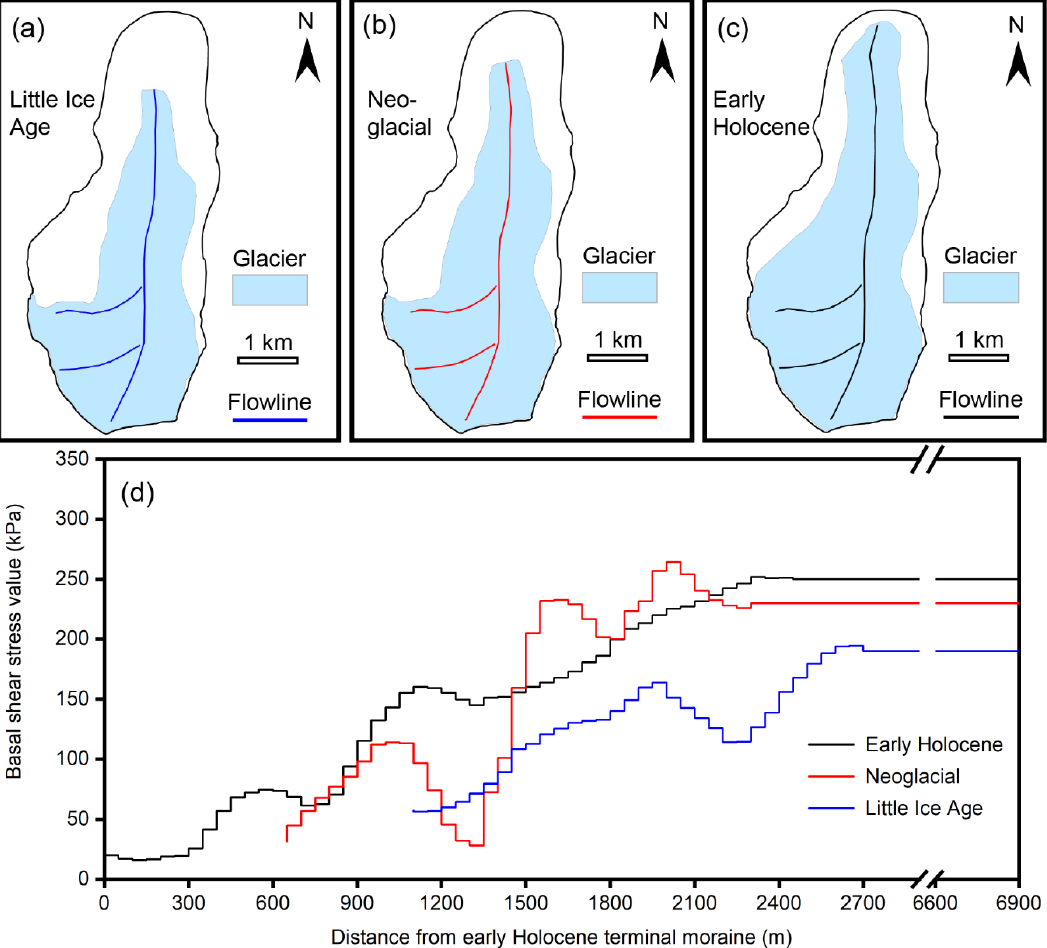
Figure 3. Glacier flowlines ( a – c ) and basal shear stress values along the glacier flowlines ( d ) of the three Holocene glaciers. The basal shear stress is kept unchanged above 2700 m.